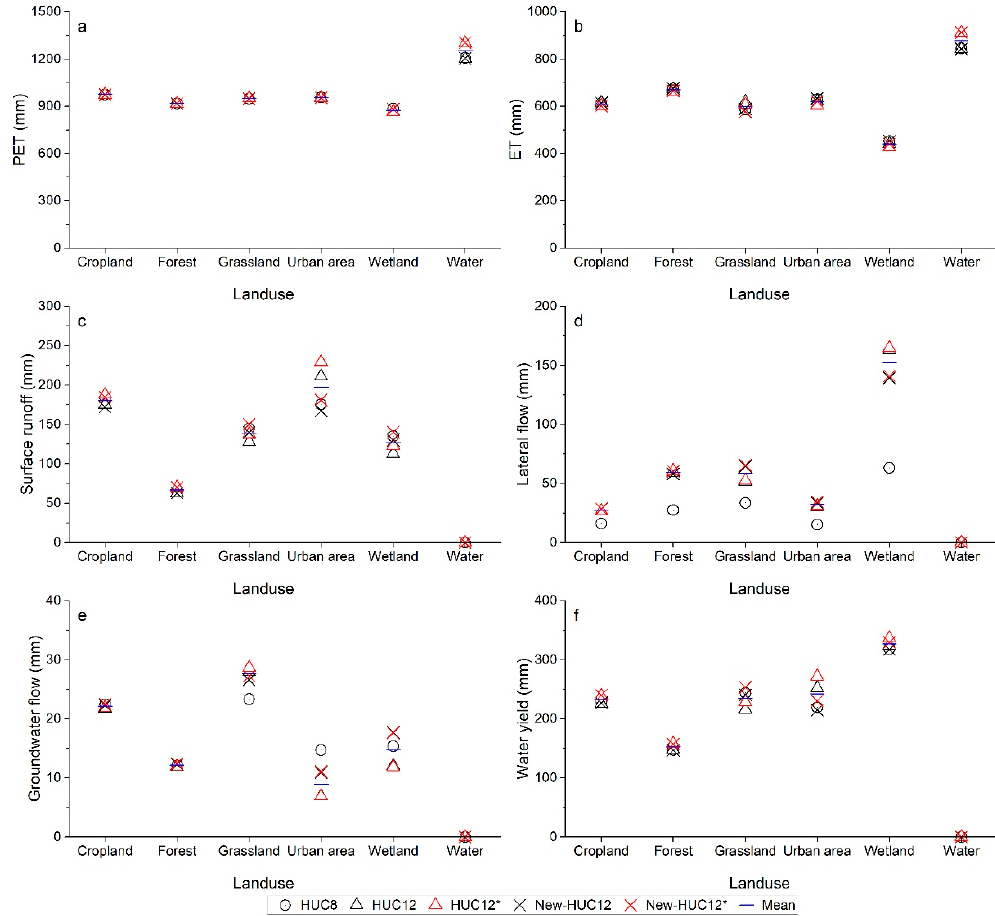
Figure 5. Spatial output of annual averages during 1983 to 2005 for Hydrologic Unit Code (HUC) 8 scenario within 8-digit subbasins ( left ) and for New-HUC12 scenario within 12-digit subbasins ( right ): ( a ) surface runoff; ( b ) lateral flow; ( c ) groundwater flow; and ( d ) water yield.